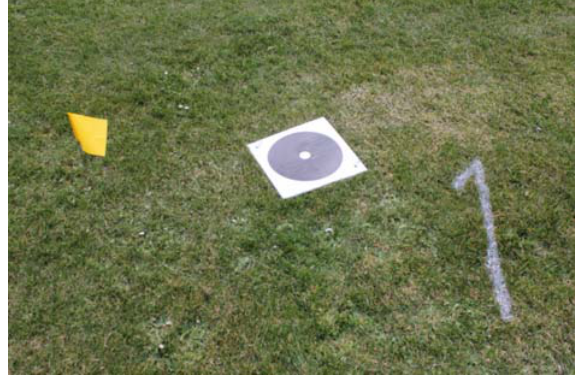
Figure 1: Ground control station and check point targets A flight plan was generated so that that an 80% overlap and a 80 % sidelap and at an altitude of 90m to provide an expected GSD of 10mm. Flight direction was plotted at 90 degrees to the actual wind direction to maintain a constant ground speed of less than 16m/s during the photographic process. This step helped to reduce ground smear, a phenomenon which blurs the pixels due to the movement of the RPAS.